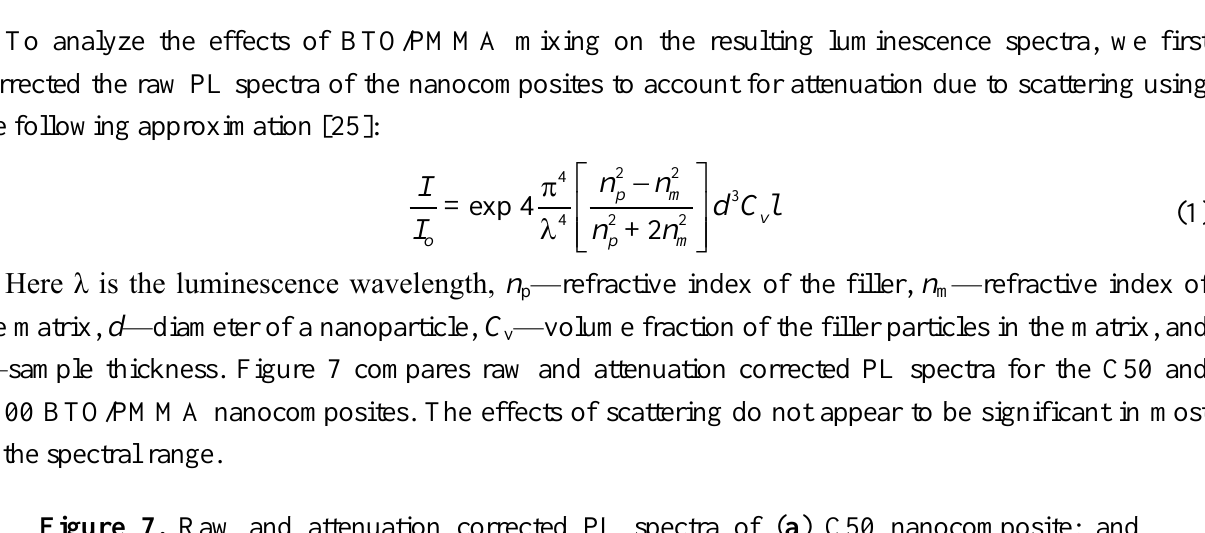
Figure 7. Raw and attenuation corrected PL spectra of ( a ) C50 nanocomposite; and ( b ) C100